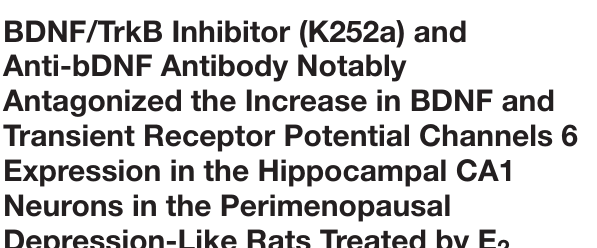
in the PD + E 2 + K + O group decreased to 11.0 ±